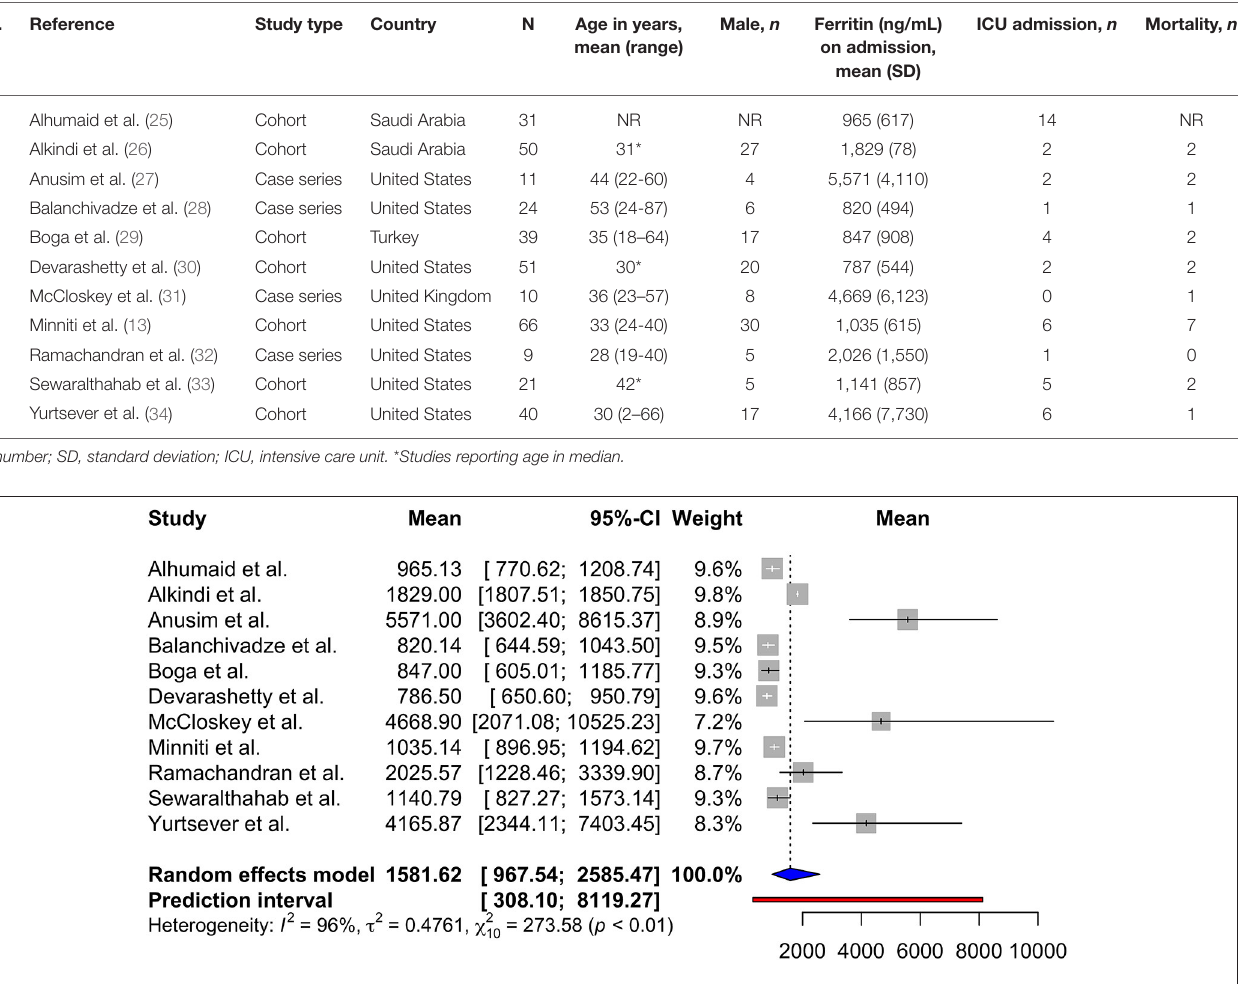
FIGURE 2 | Forest plot showing mean serum ferritin (ng/mL) on admission.